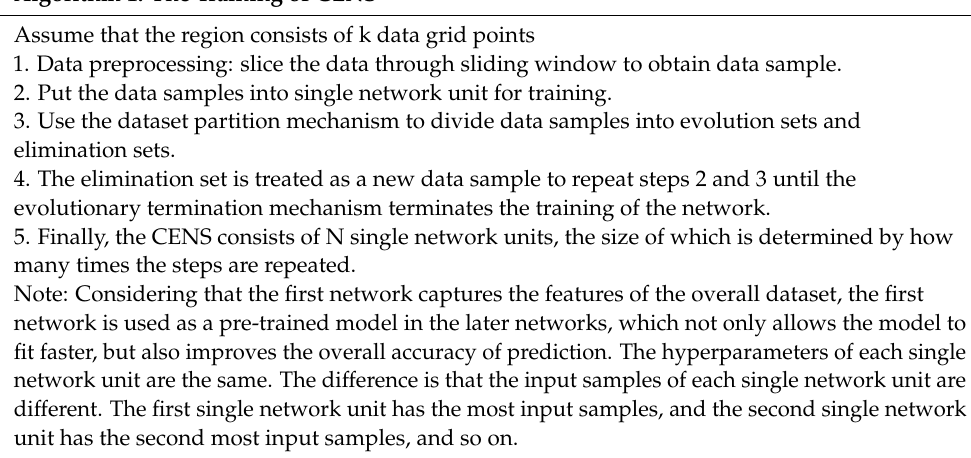
Algorithm 1. The Training of CENS